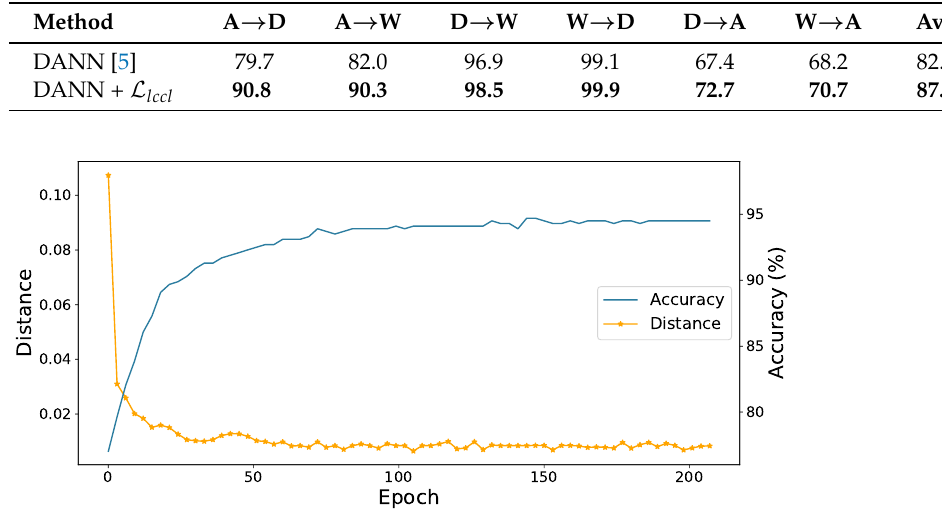
Figure 5. The accuracy of the model and average distance between sample and centroid with the epoch of training time on the A → D task in office-31.